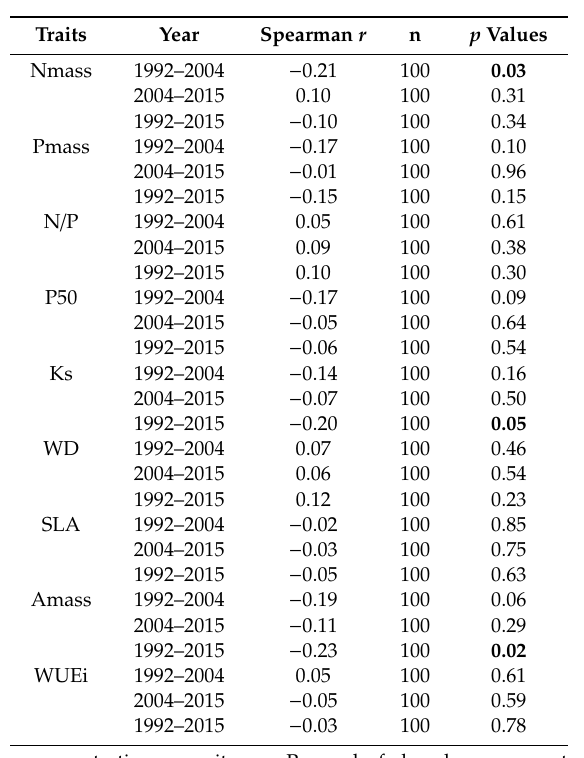
Table A2. Spearman rank correlations between quadrats’ initial BA (basal area) and subsequent rates of change in trait